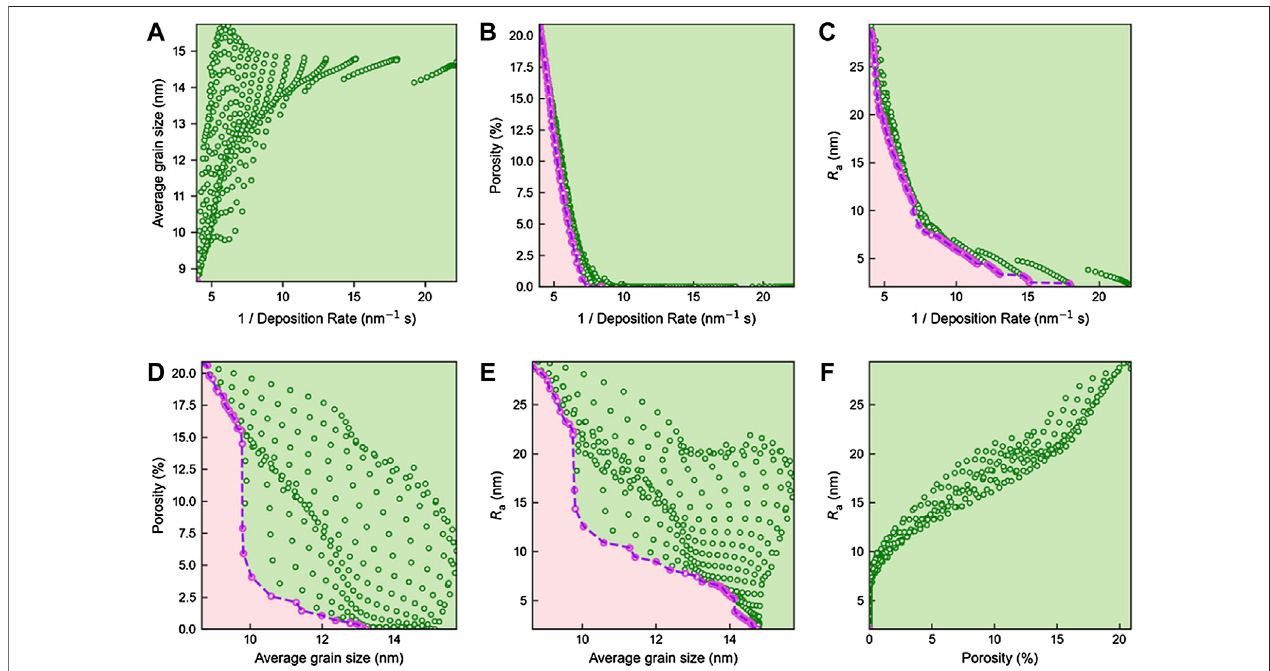
FIGURE 9 | Mathematical optimal solutions (Pareto frontier) for simultaneous optimization of multiple objectives: (A) deposition rate and grain size, (B) deposition rate and porosity, (C) deposition rate and surface roughness, (D) grain size and porosity, (E) grain size and surface roughness, and (F) porosity and surface roughness.